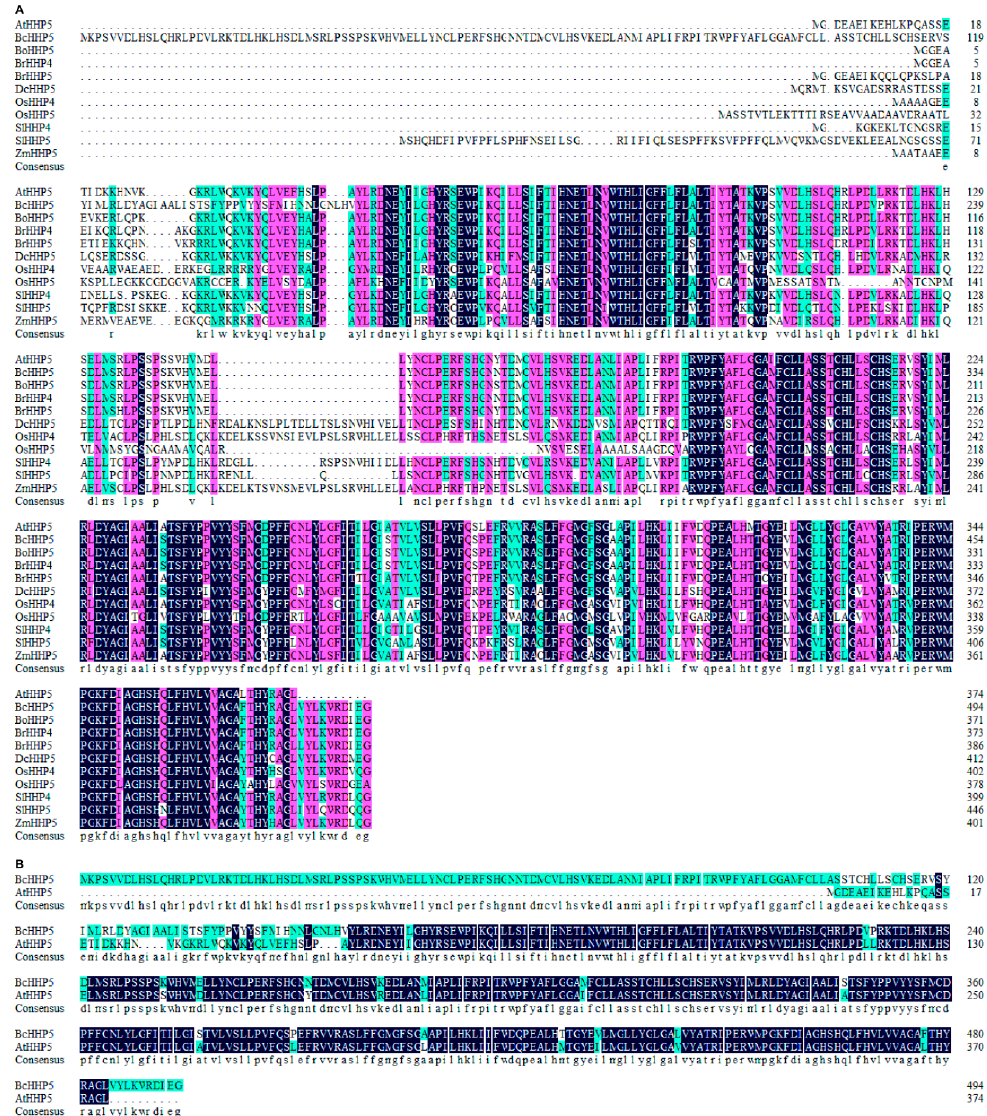
Figure 1. Multiple sequence alignments corresponding to the encoded amino acid sequences on the 11 heptahelical protein ( HHP) genes. ( A ) In this study, HHPs in Pak-choi (BcHHPs) were isolated and other crop proteins were also selected from GenBank; ( B ) BcHHP5 and Arabidopsis thaliana heptahelical proteins (AtHHP5) were isolated in the study and selected from GenBank. Less conservative, highly conservative, and perfectly matched residues are represented by green boxes, pink boxes, and black boxes,